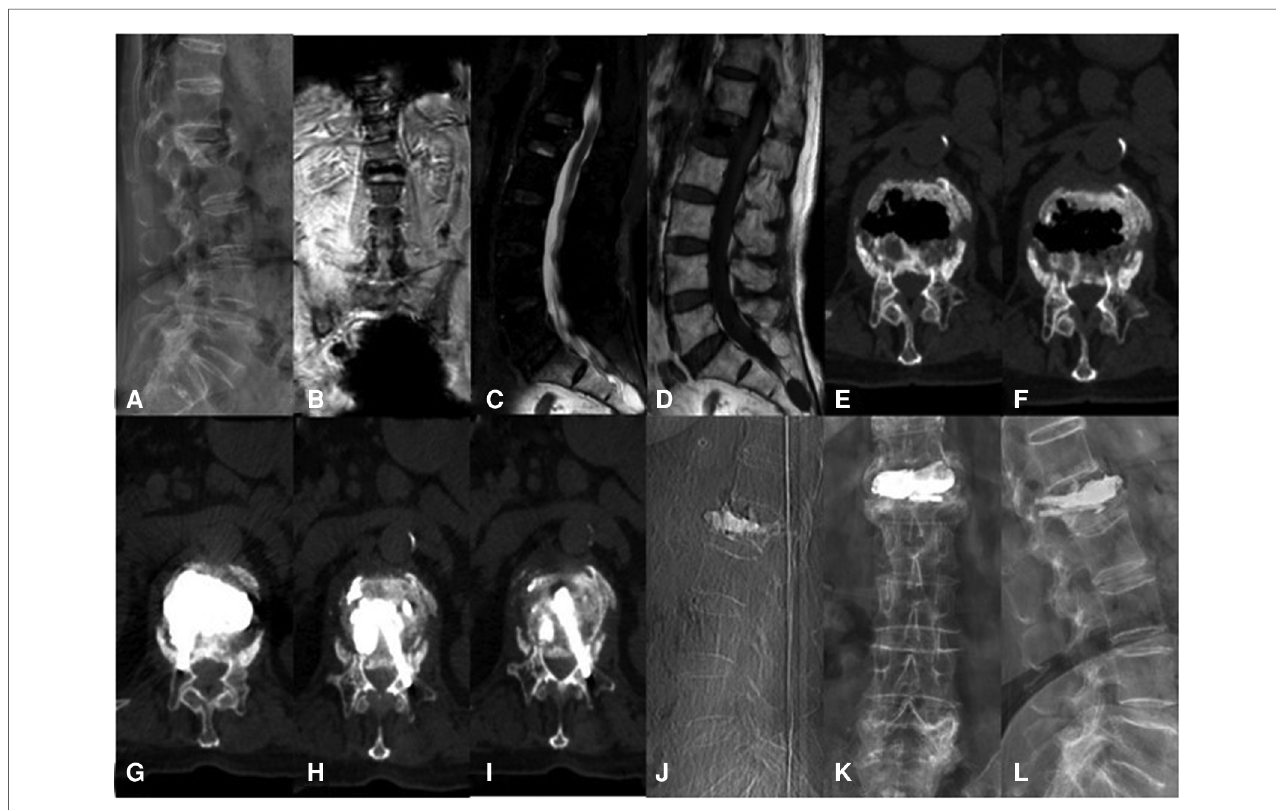
FIGURE 3 A 76-year-old woman with KD at L1 treated using the bilateral pedicle anchoring technique with PVP: ( A ) preoperative radiographic images; ( B,C ) coronal and sagittal T2-weighted MR image showing low signal intensity at L1; ( D ) the sagittal T1-weighted MR image showing low signal intensity at the same location; ( E,F ) CT scans showing the intravertebral vacuum sign; ( G – J ) CT scans after operation showing the bone-cement- fi lled cleft and vertebrae; bone cement dispersion was observed in both pedicles; ( J – L ) x-ray at 14 months after operation showing no delayed displacement of bone cement or adjacent vertebral fracture. KD, Kümmell ’ s disease; PVP, percutaneous vertebroplasty.